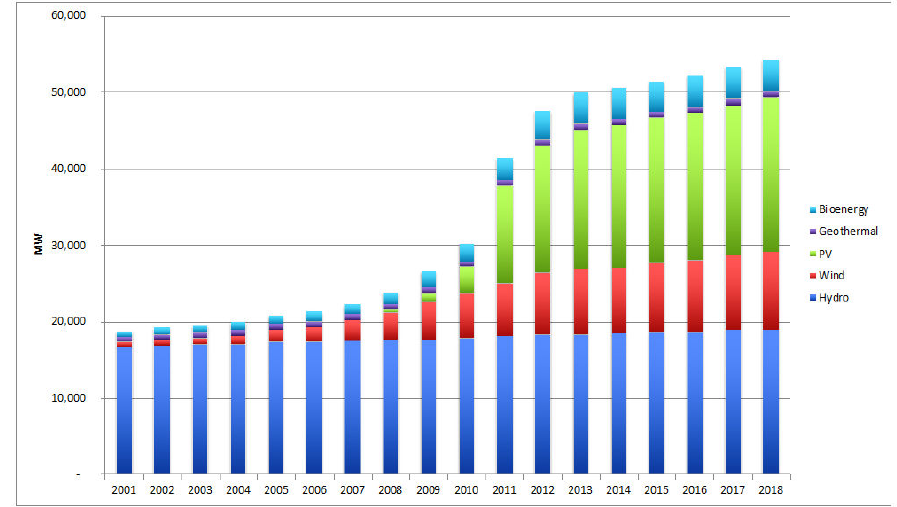
Figure 3. Renewable cumulative installed capacity in Italy (MW), 2001–2018 (data collected from reports by the Gestore dei Servizi Energetici (GSE)) [48–52].